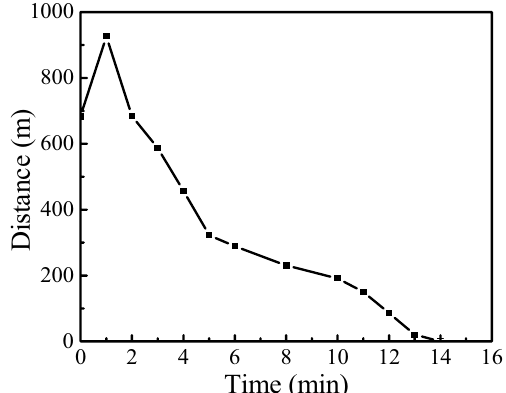
Fig. 5 A graph of distance against time for user walking along a specified path from main gate to Kiwanja market in XX university using the developed mGuide application. The speed decreases gradually to